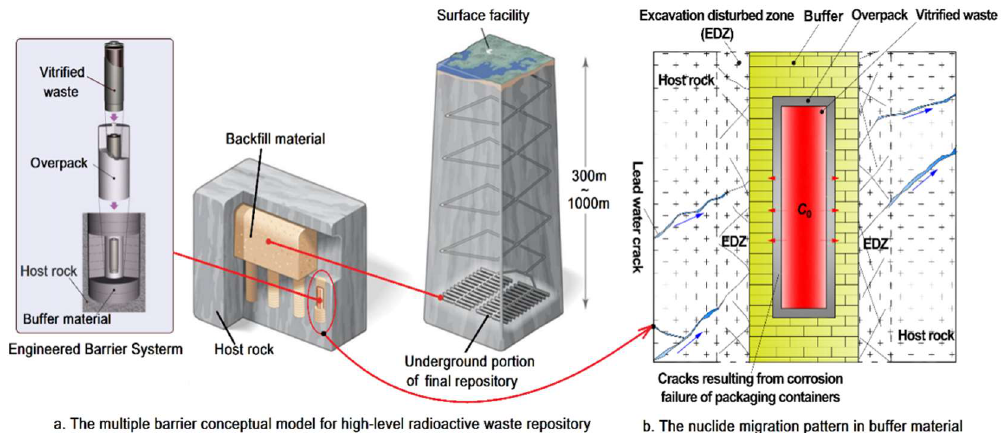
Figure 2. The nuclide migration pattern in buffer material under near-field environmental conditions (part of the content is quoted from reference [5,18,56]).